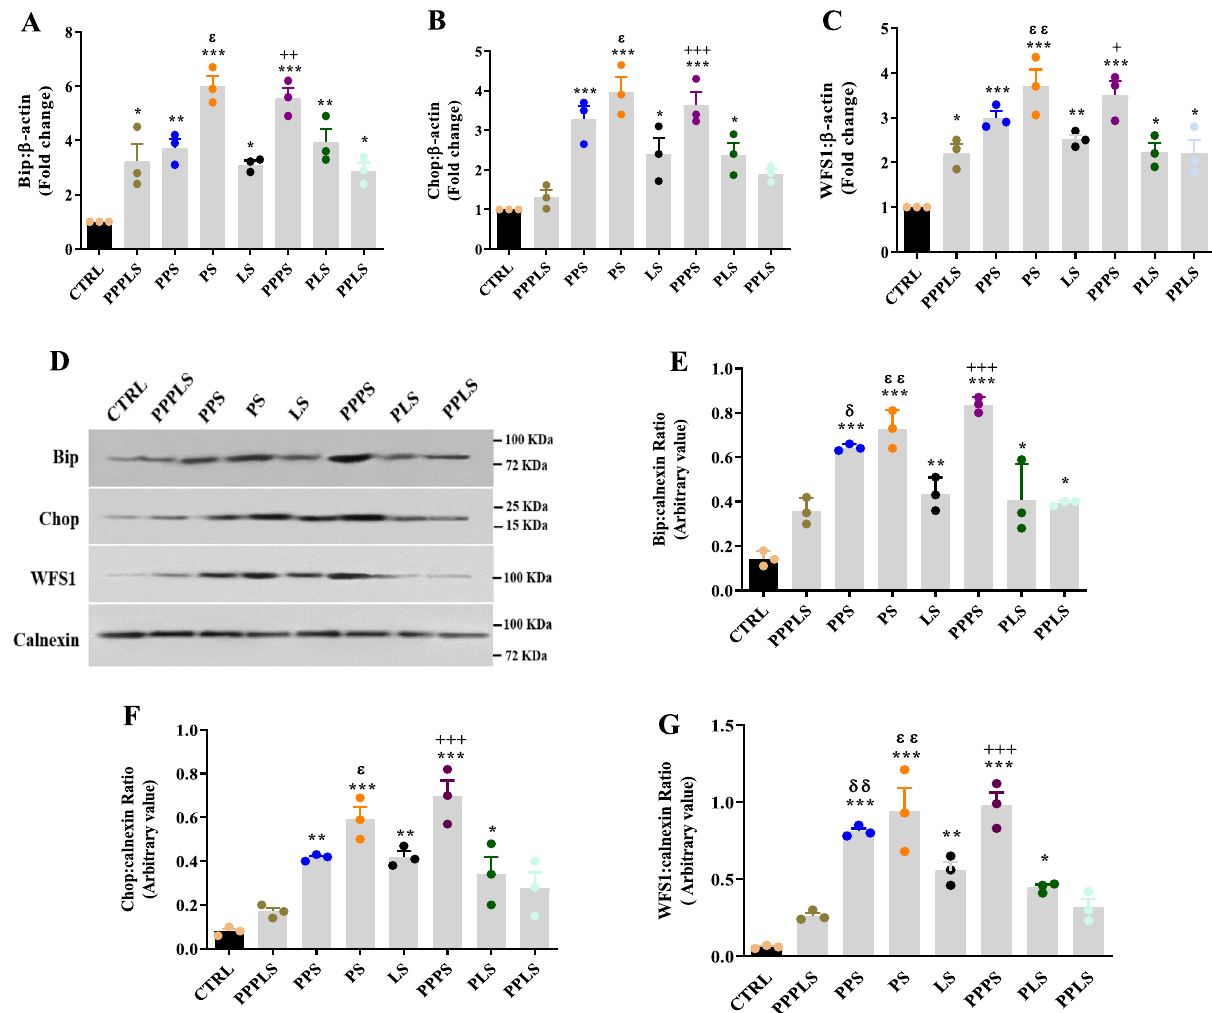
Figure 5. Effect of perinatal stress on pancreatic tissue Bip ( A ), Chop ( B ), and WFS1 ( C ) mRNA expression and pancreatic extracted ER levels of Bip ( D , E ), Chop ( D , F ) and WFS1 ( D , G ) proteins in young adult male offspring. Representative figures for the RT-PCR are shown the fold change (3 rats/group, 3 litters/group) and representative bands are shown the respective densitometric values (8 rats/ group, 8 litters/group). Twenty μg proteins were separated on SDS-PAGE, western blotted, probed with anti-Bip antibody, anti-Chop antibody, and anti-WFS1 antibody and reprobed with anti-Calnexin antibody ( D ) The densities of proteins bands are measured, and the ratio is calculated ( E – G ). Each column represents mean ± SEM. Data was analyzed using one- way ANOVA followed by Tukey’s post hoc test; * P < 0.05, ** P < 0.01, *** P < 0.001 versus CTRL group; + P < 0.05, ++ P < 0.01, +++ P < 0.001 versus PPPLS group; ɛ P < 0.05, ɛɛ P < 0.01 versus PLS group; δ P < 0.05, δδ P < 0.01 versus PPLS group. CTRL non stress, PPPLS pre-pregnancy, pregnancy, lactation stress, PPS pre-pregnancy stress, PS pregnancy stress, LS lactation stress, PPPS pre-pregnancy, pregnancy stress, PLS pregnancy, lactation stress, PPLS pre-pregnancy, lactation